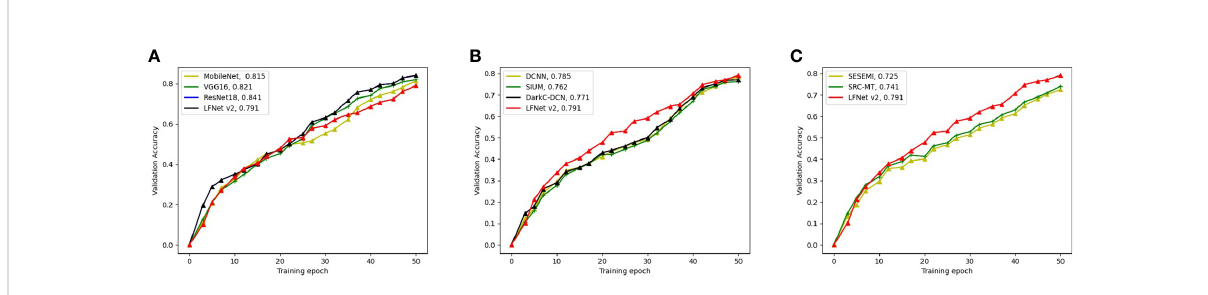
FIGURE 6 Study on the performance of wild fi re scene image classi fi cation algorithm. (A) denotes the classi fi cation accuracy of the commonly used superintendency image classi fi cation algorithm; (B) denotes the classi fi cation accuracy of the commonly used superintendency image classi fi cation algorithm; and (C) denotes the classi fi cation accuracy of the commonly used semi-superintendency image classi fi cation algorithm.